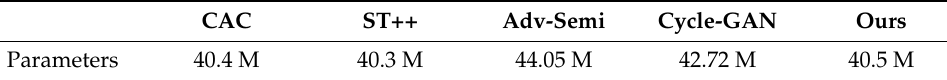
Table 5. Parameters of each model.